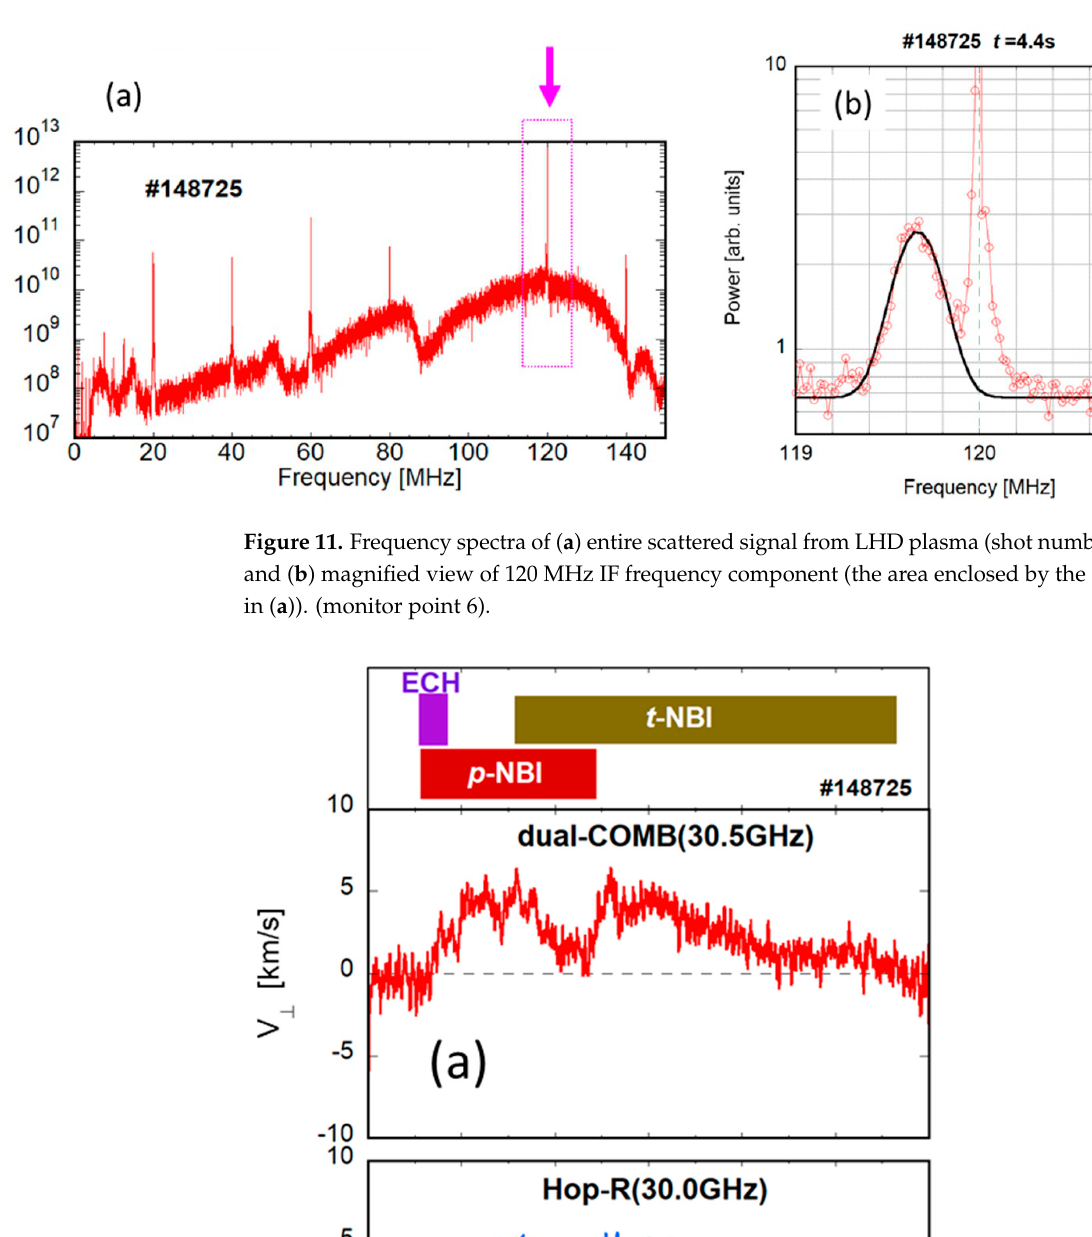
Figure 12. Temporal behavior of plasma perpendicular flow velocity obtained with ( a ) dual comb system at 30.5 GHz and ( b ) frequency-hopping Doppler reflectometer system operated at fixed 30.0 GHz, respectively. Shot number of LHD plasma is #148725. The injection timing of heating power for ECH, p-NBI, and t-NBI is shown above in color bar. 5. Conclusions A Ka-band dual-comb Doppler reflectometer has been developed to simultaneously measure turbulence intensity and its velocity in high-temperature plasmas at multiple spatial points. This dual-comb method has the potential to significantly reduce the IF fre- quency, compared to the conventional frequency comb method. Using this method, we confirmed that the velocity of a rotating object can be observed as a Doppler shift on a